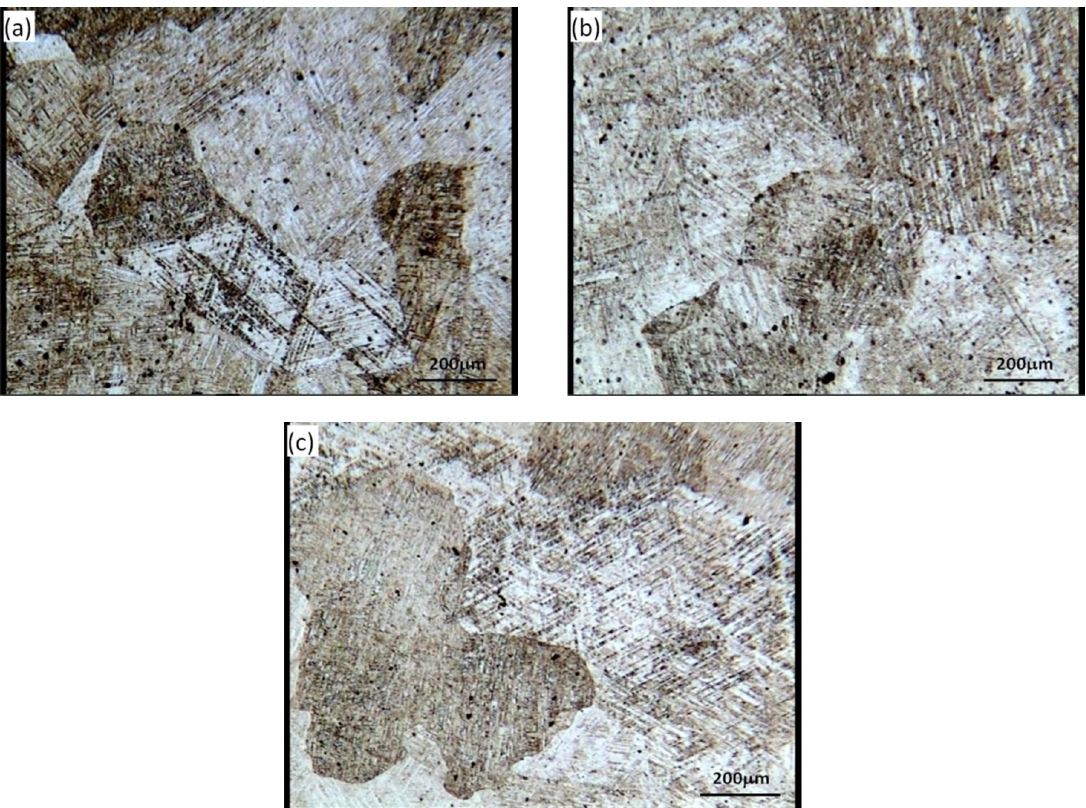
Figure 5. Optical micrographs of the samples (a) furnace cooled, (b) air cooled, and (c) water quenched. Samples were etched with 4%